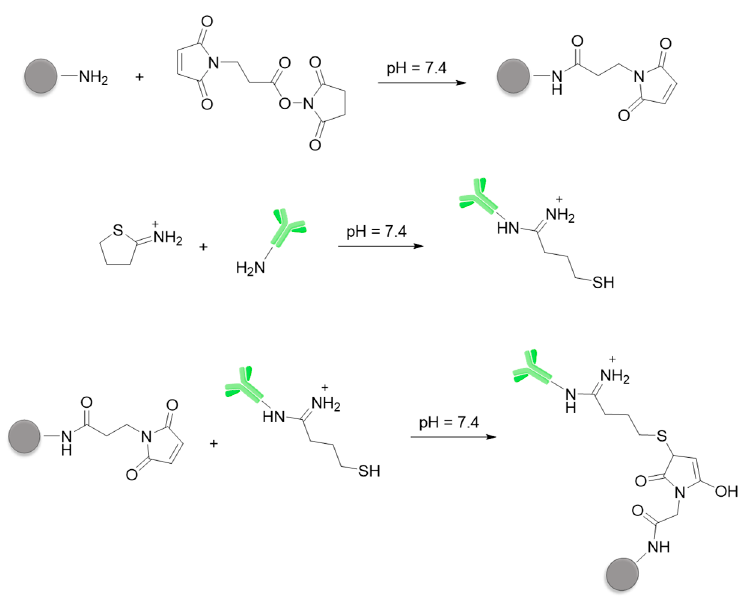
Figure 3. Conjugation of NH 2 -NPs with the antibody anti-CD44v6.